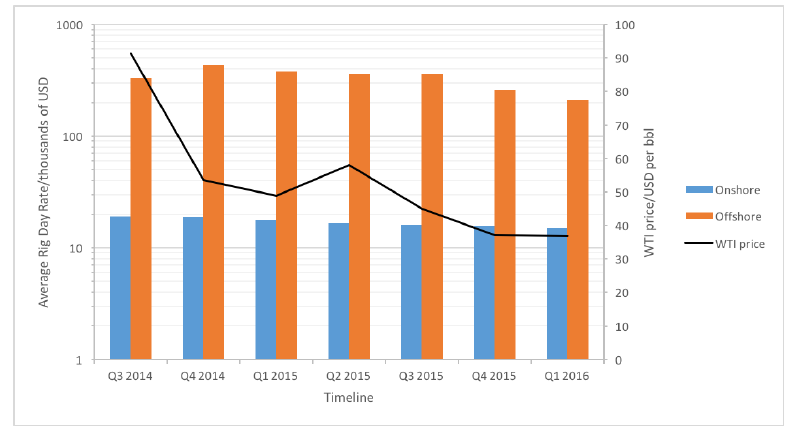
Figure 1. Estimates of rig rates and the price of West Texas Intermediate crude oil (WTI) during the oil price collapse in 2014/2015 [19 – 21].